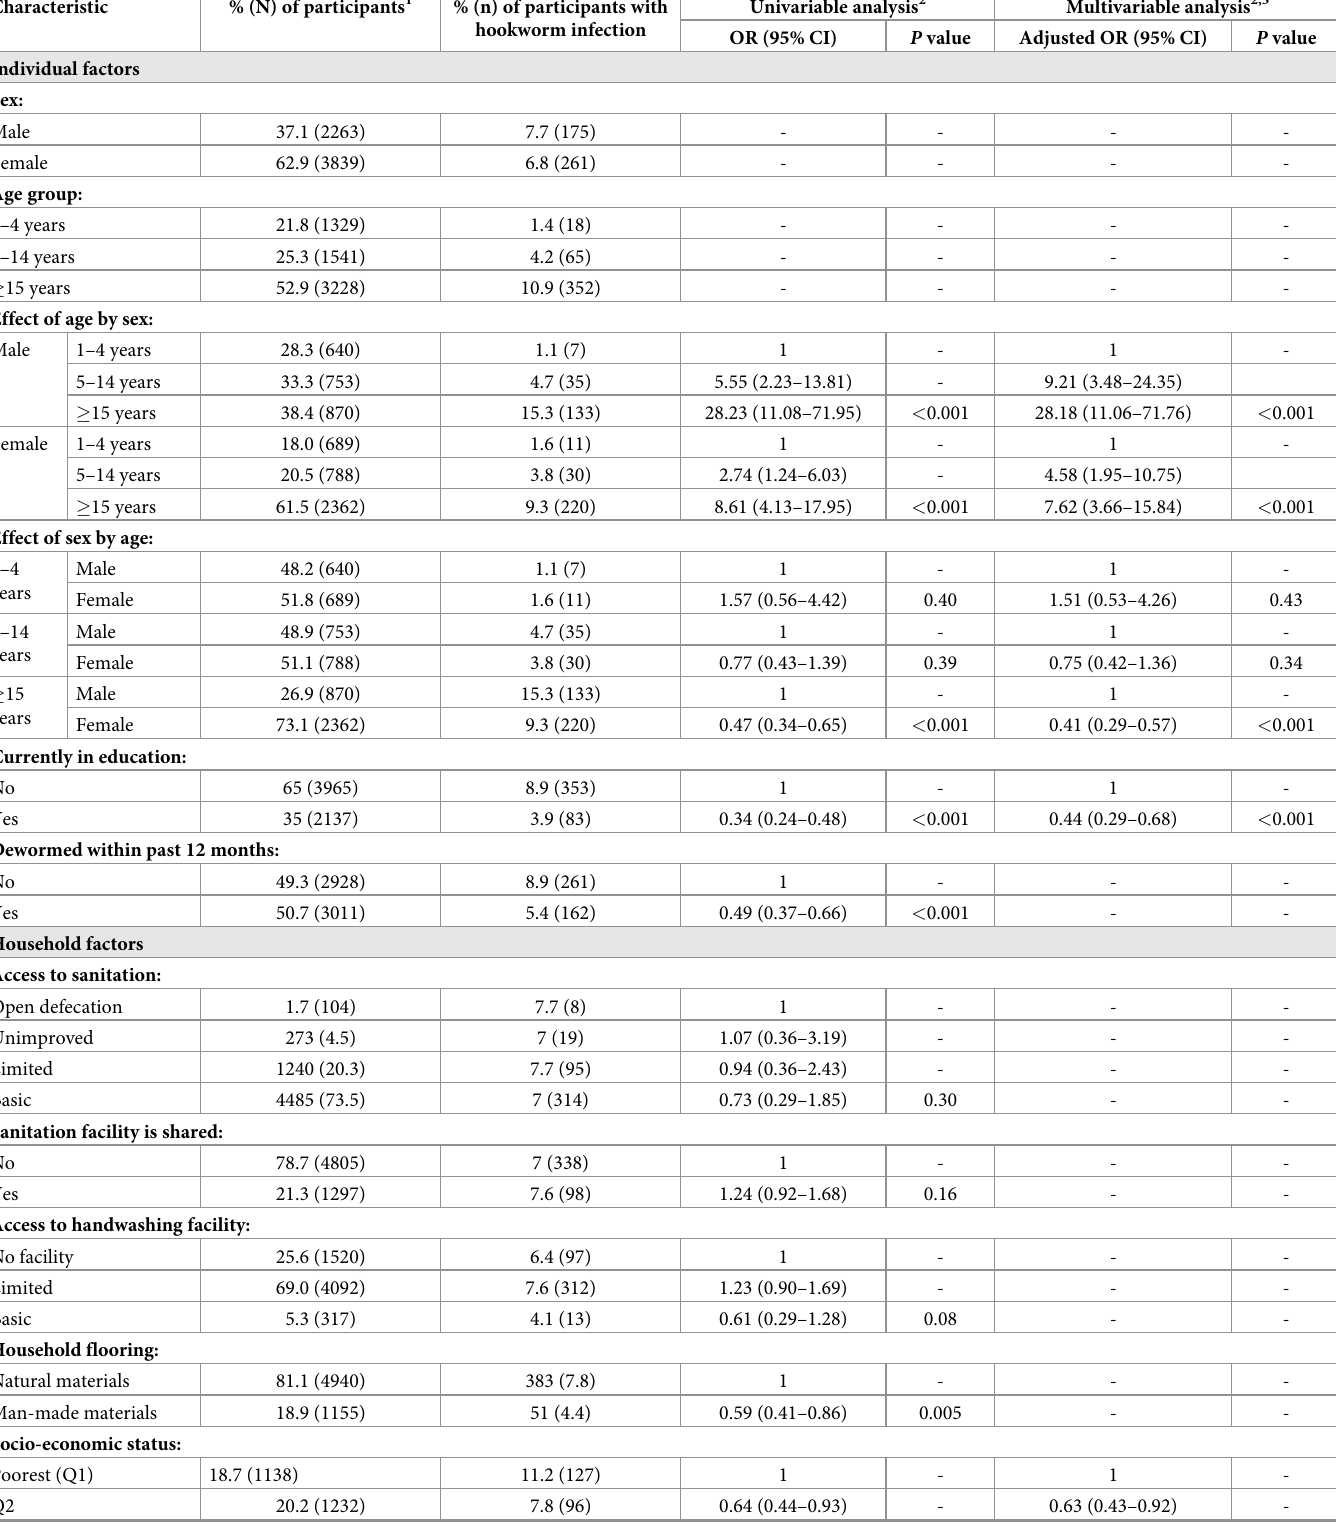
Table 2. Predictors of presence of hookworm infection amongst preschool-age children, school-age children, and adults in Namwera, Mangochi district, Malawi in 2018.